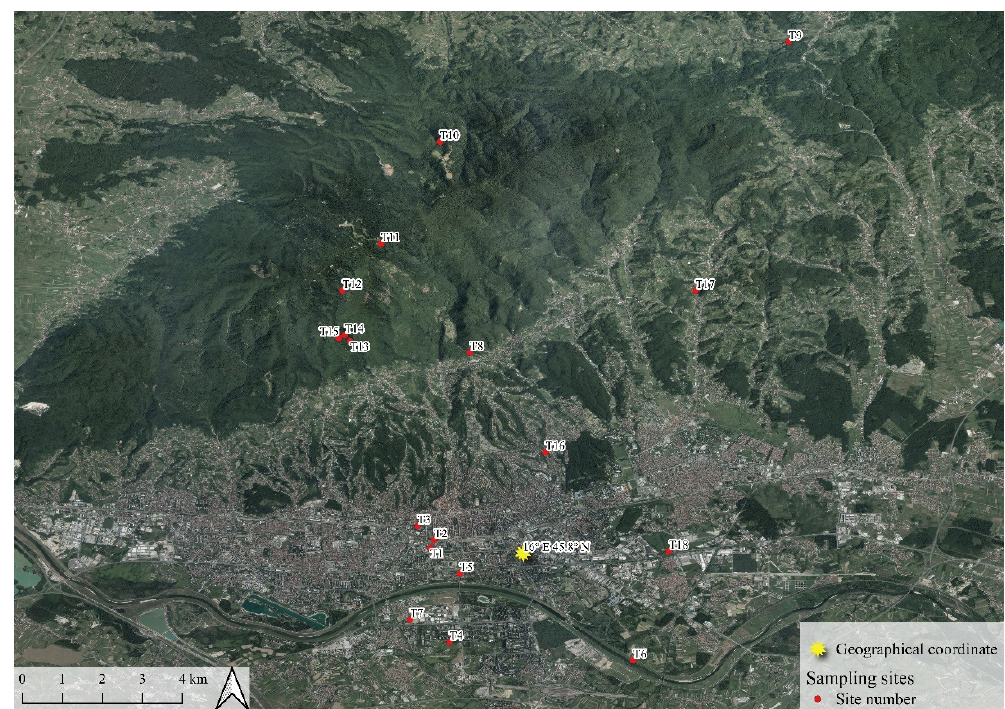
Figure 1. Sampling locations of E. annuus populations in the area of Zagreb and Medvednica Mt. Croatia. Table 1. Basic information on dates (during 2019) and sampling locations (with WGS84 coordinates) of E. annuus populations, along with short habitat descriptions and altitudes. Site